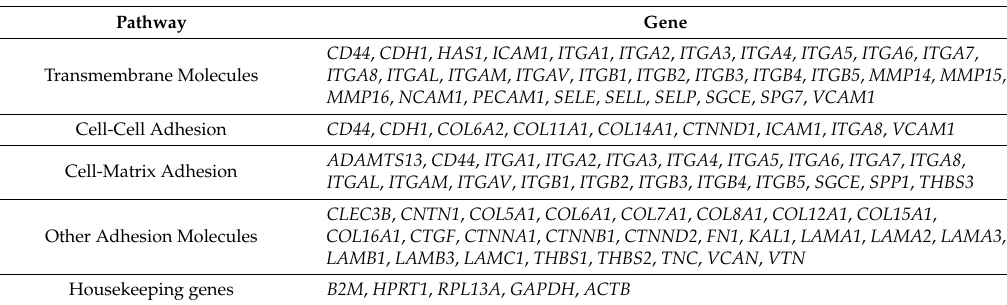
Table 2. Functional CAM gene grouping.